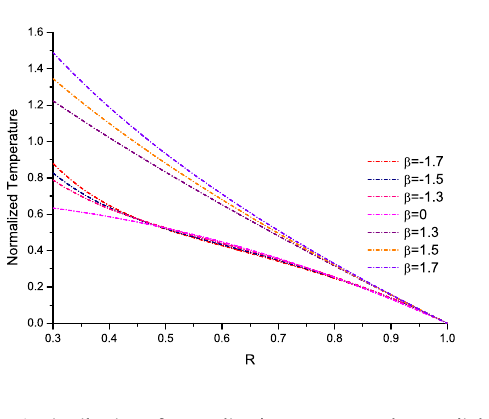
• Particular cases of Poisson’s ratio study by assigning dif- ferent values to ν . The behaviour of normalized stress is highly fluctuating when ν =